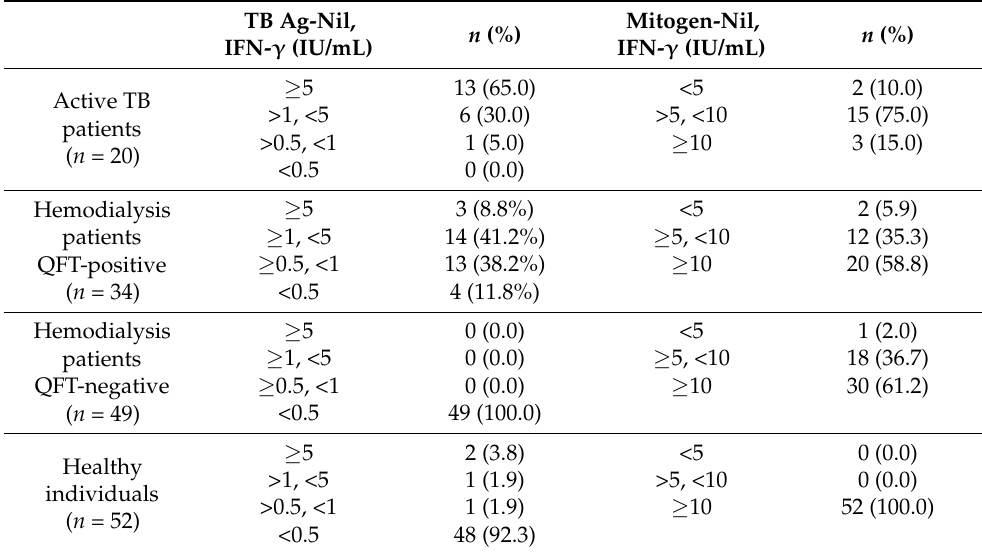
Table 3. Comparison of IFN- γ production TB antigen